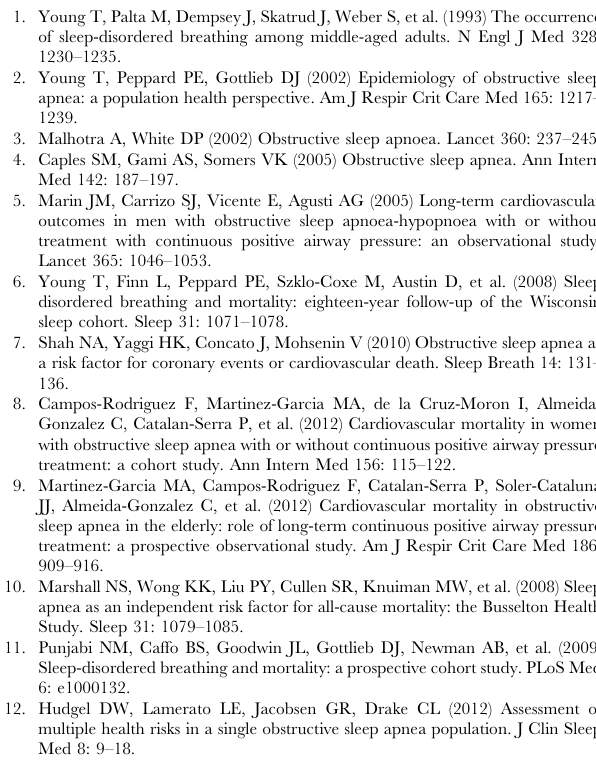
eligible studies of cardiovascular